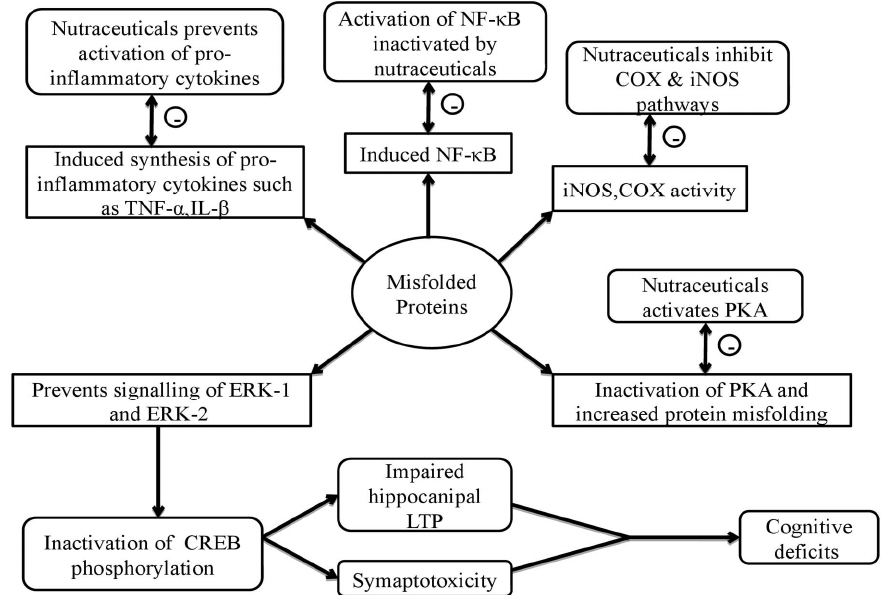
Figure 2. Summarized pathogenesis of misfolded proteins and neurodegeneration mediated upon their activation. The misfolded proteins lead to the activation of cascade of inflammatory proteins, such as nuclear factor kappa-light-chain-enhancer of activated B cells (NF-κB), inducible nitric oxide synthase (iNOS), and cyclooxygenase (COX), and activation of interleukins and inflammatory cytokines, which leads to inflammation and further neurodegeneration. Inhibition of these cascade proteins by active nutraceuticals tends to provide neuroprotective